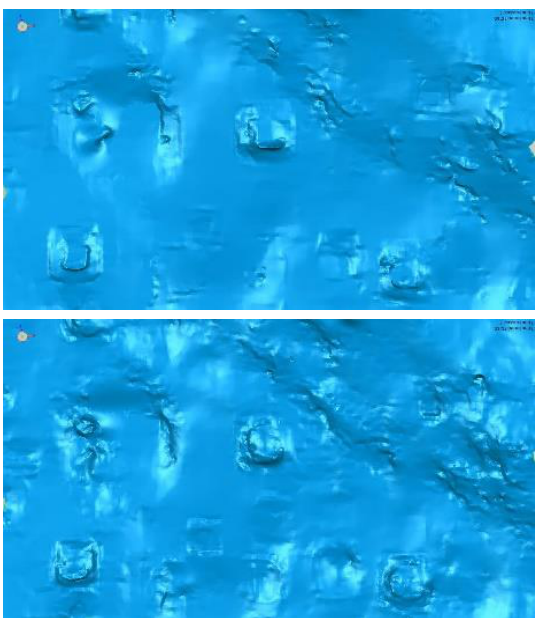
Figure 9: Level of detail of the DTMs processed. Top: with Affine model. Bottom: with Polynomial model.